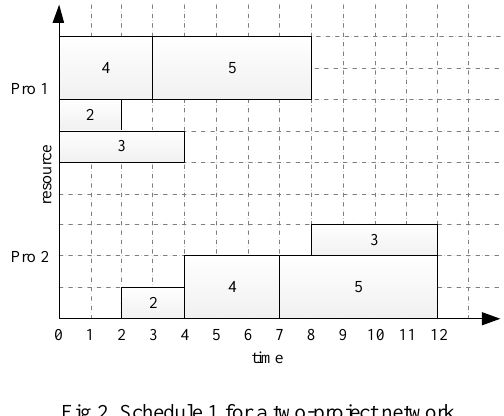
Fig.2. Schedule 1 for a two-project network